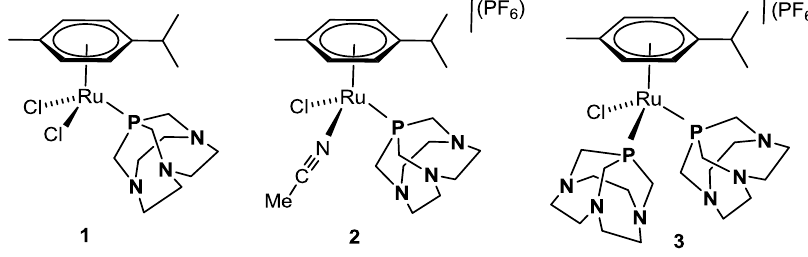
Figure 2. Ru(II)-arene complexes 1 3 bearing ligand CAP [22].